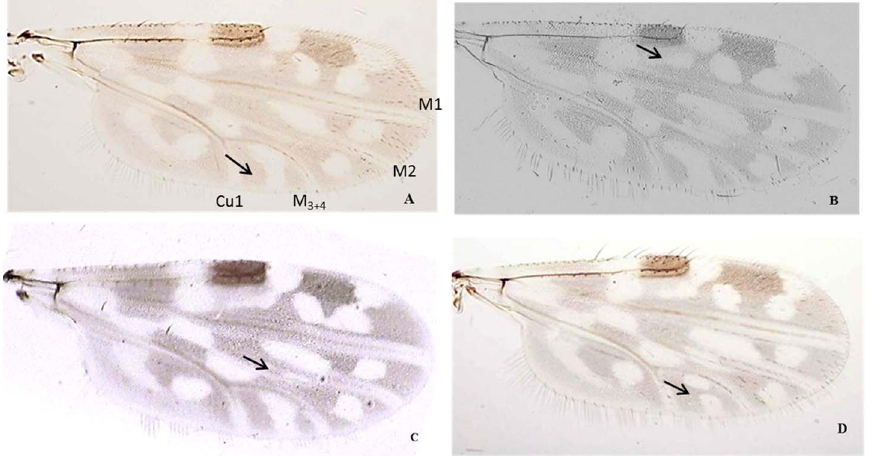
Figure 3. Variation in the wing patterns of C.subschultzei and C.oxystoma found in Senegal: Culicoidessubschultzei typical form (A), Culicoidesoxystoma typical form (B) and morphological variants: absence of pale spots in the second median cell (C) and presence of two pale spots in cubital cell (D).